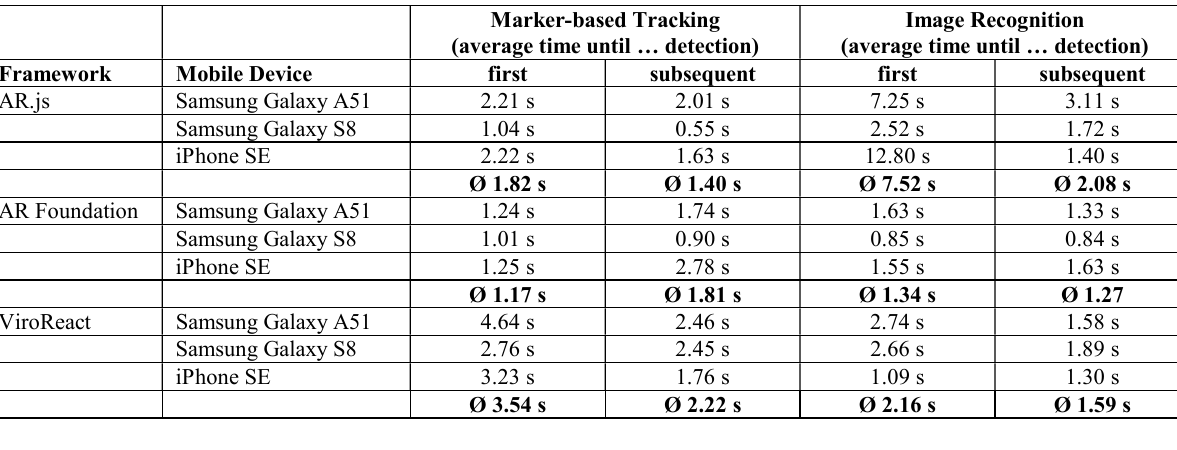
Table 2. Comparison of the average time (in seconds) required by the frameworks to detect a marker or image and display the